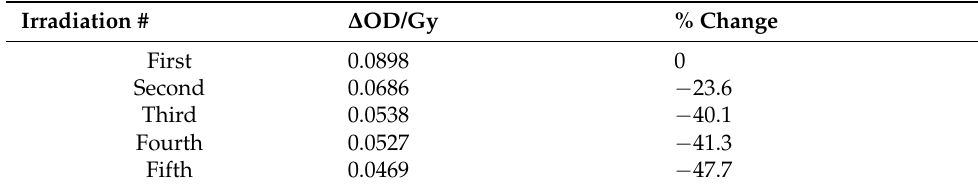
Figure 7. Five separate irradiations of Formulation 1 with seven cuvettes ranging from 0.5–10 Gy dose. The reirradiations were performed well after the cuvettes had cleared back to a stable baseline OD following the previous irradiation. Least squares linear fits to each of the five data sets are shown above, with the R 2 coefficient included for each. Table 2. Formulation 1 sensitivity measurements for five successive irradiations along with the percent change from the initial sensitivity.